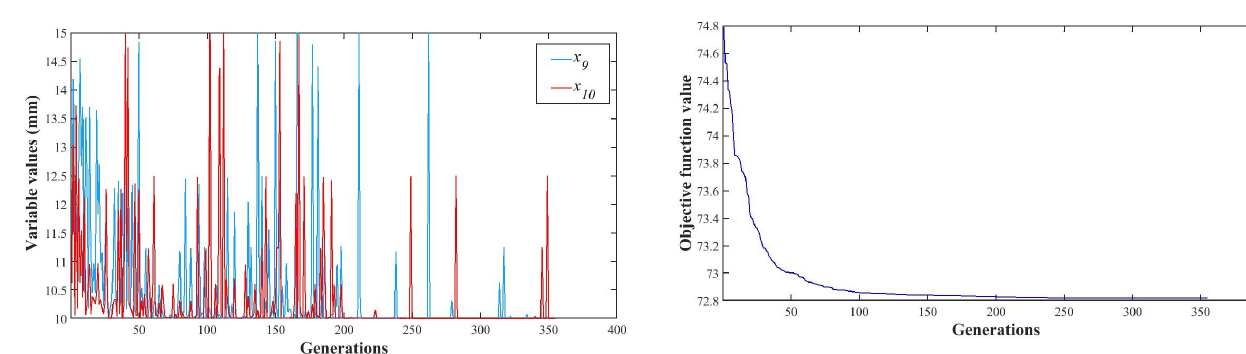
Figure 16. Variations of the design variables under different num- bers of generation.